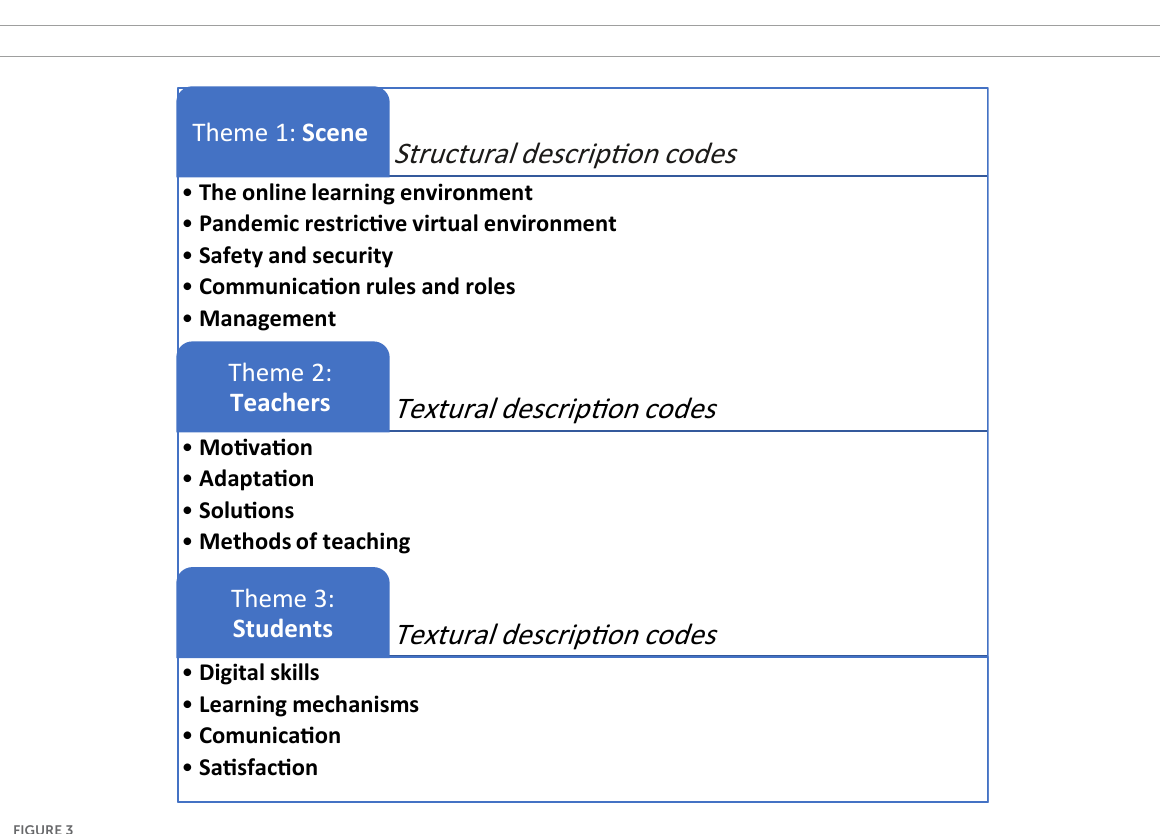
culture, background, and information that is exchanged in the virtual environment, as well as of the robotics terminology that supports the authenticity of the results from forms of